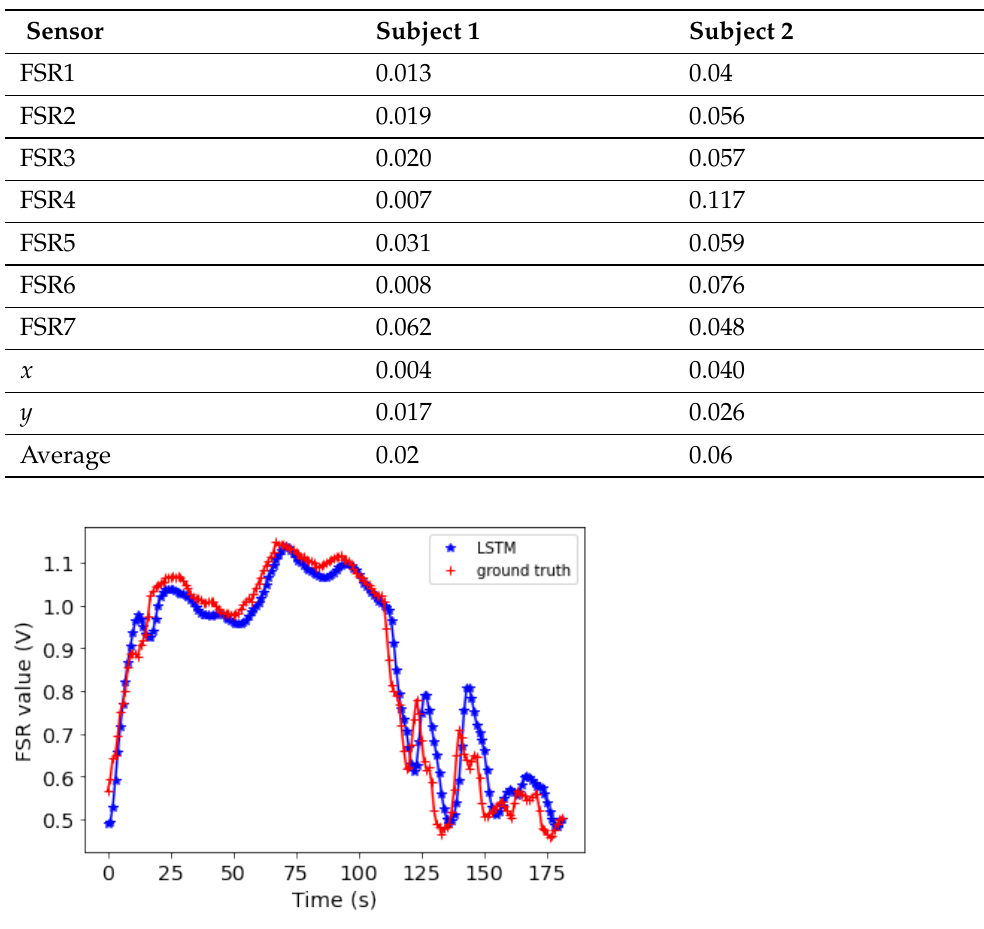
Figure 9. Subject 1: The 1D-CNN-LSTM forecasting values for the next 180 s (blue points) plotted against the actual values (red points) for FSR Number